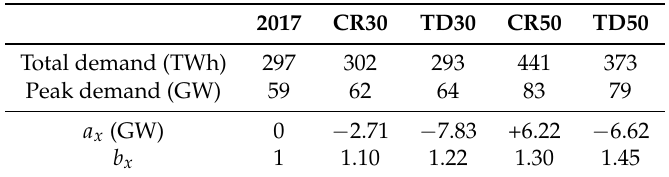
Table A2. Scaling and shifting parameters a x and b x to transform 2017 demand series D 17 ( t ) into series appropriate for future scenarios in terms of total and peak